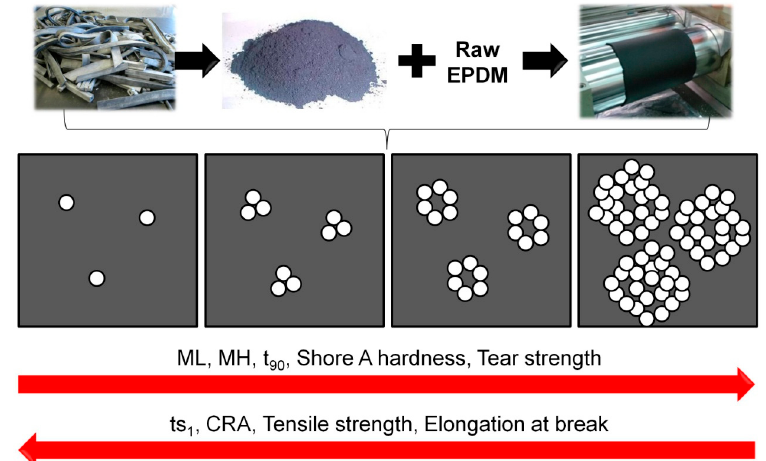
Figure 8. Schema of the influence of the residue content on the vulcanization characteristics and on the mechanical properties of the blends. The gray color represents the matrix phase (raw EPDM), and the white circles represent the ground residue phase.